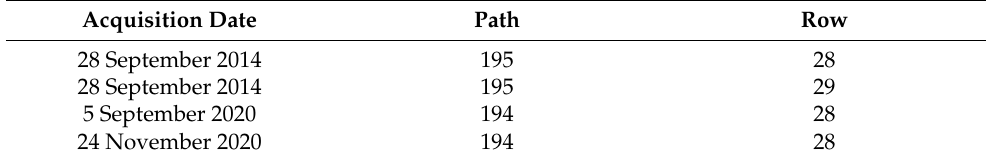
Table 3. Landsat 8 product used for model’s ground-truth data labeling.